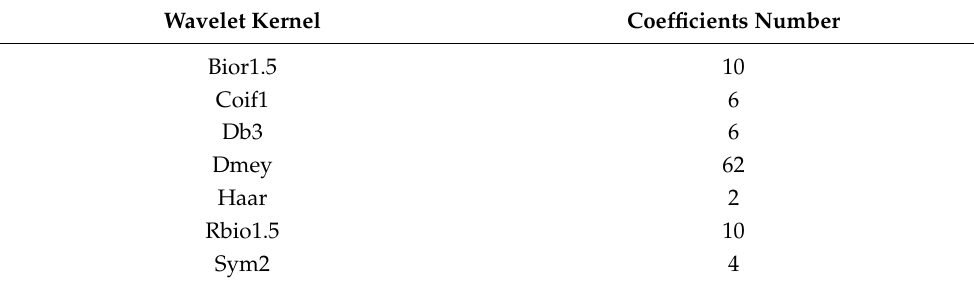
Table 1. Number of coefficients that define the kernel